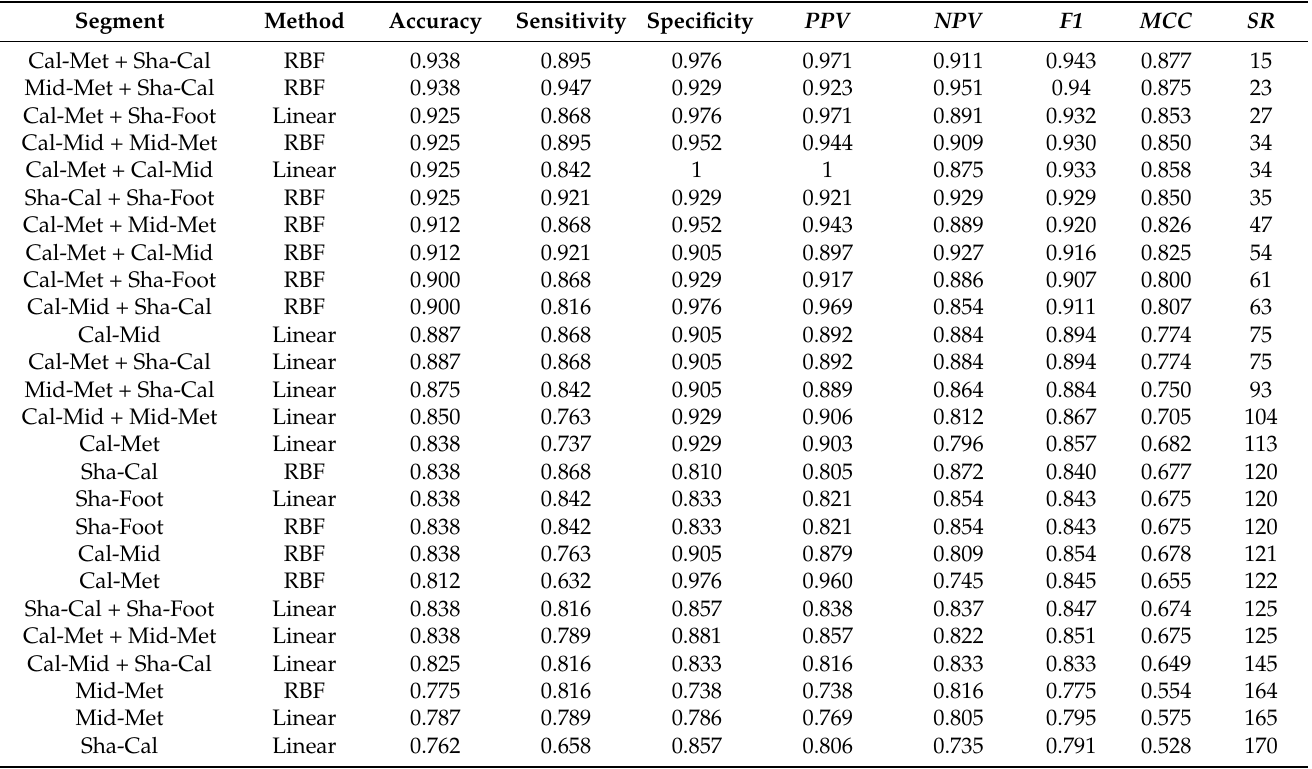
Table 2. Classification models based on level-1 and level-2 combinations of SSF and MSF